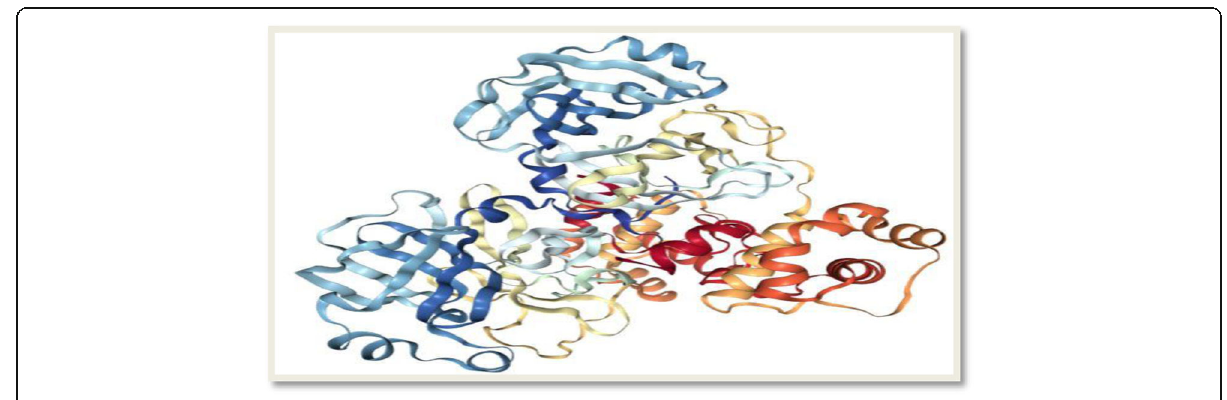
Fig. 1 Dimeric crystal structure of the SARS coronavirus main proteinase (source